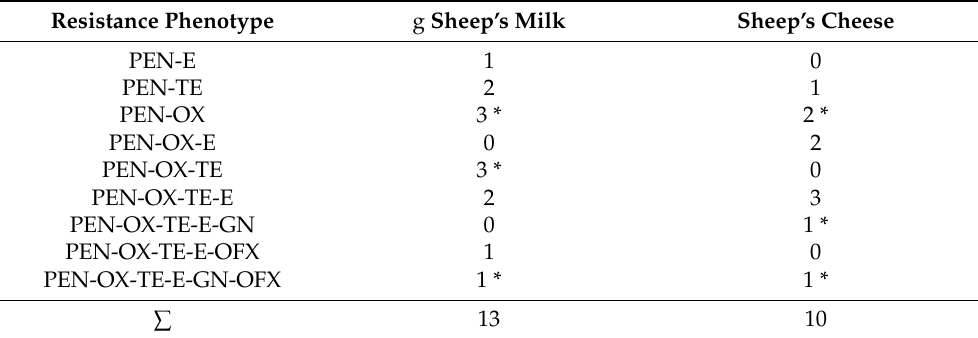
Table 3. Identified phenotypes of resistance of staphylococcal isolates to several antibiotics simulta-